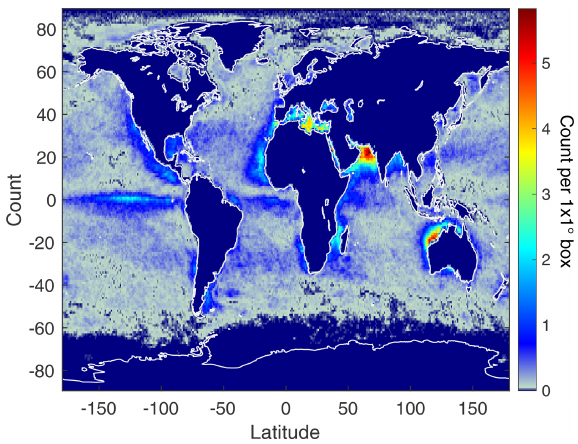
Figure 1. Density of AIRS clear ocean scenes for the calendar year of 2012.